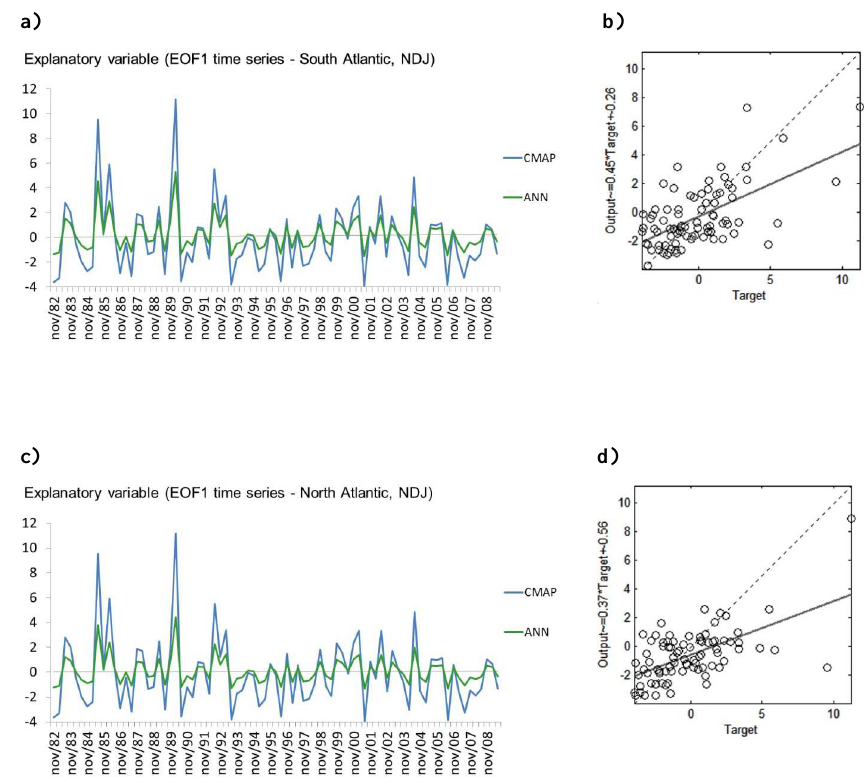
Fig. 8. Validation results for NDJ season when the time series of the (a) South Atlantic Dipole and (c) North Atlantic Oscillation modes were used as explanatory variables. On the left-hand column is the monthly time series of observed (blue) and downscaled anomalous precipitation (green). On the right-hand column is the corresponding scatterplots (b) and (d) , respectively. The R-values are 0.59 and 0.58 for panels (b) and (d) , respectively. The scatterplots are adapted from the Matlab tool and solid gray line represents the fit